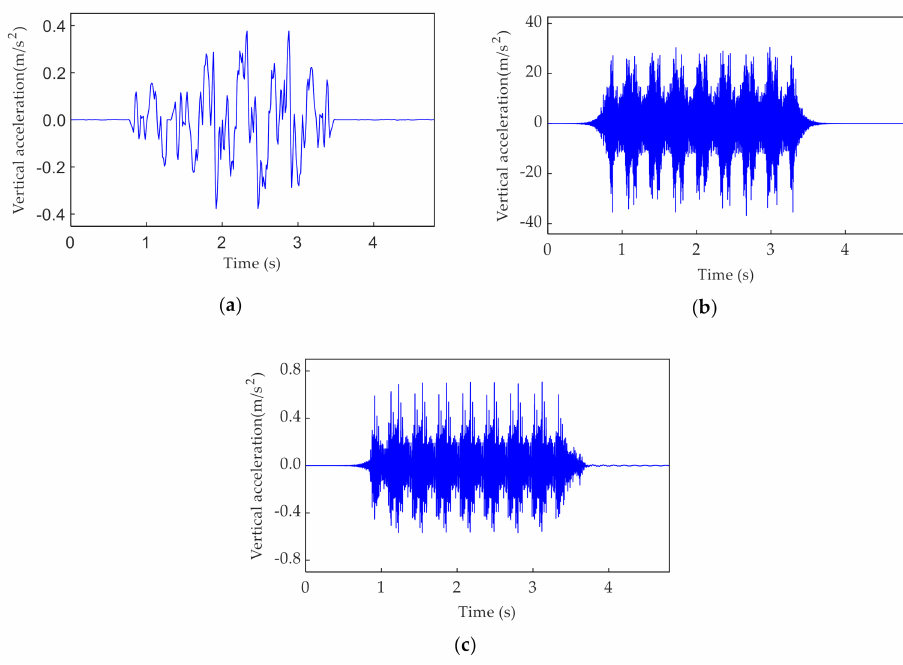
Figure 8. Time history of vertical acceleration of the: ( a ) car body; ( b ) rail; ( c )